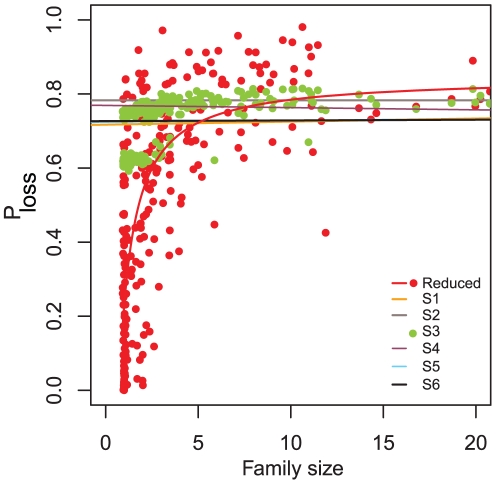
Gene loss depends on degree of paralogy.Probability of gene loss in families present in most reduced genomes (Red points) shown as a function of protein family size. The Red line is an inverse function fitted to the Reduced families. Colored lines represent the results of the different simulations, as indicated in the lower right corner, showing that under these scenarios Ploss is independent of family size. The Green points are the Reduced families simulated under scenario S3, showing that although there are two distinct Ploss levels hardwired into the simulation, they are both independent of family size.